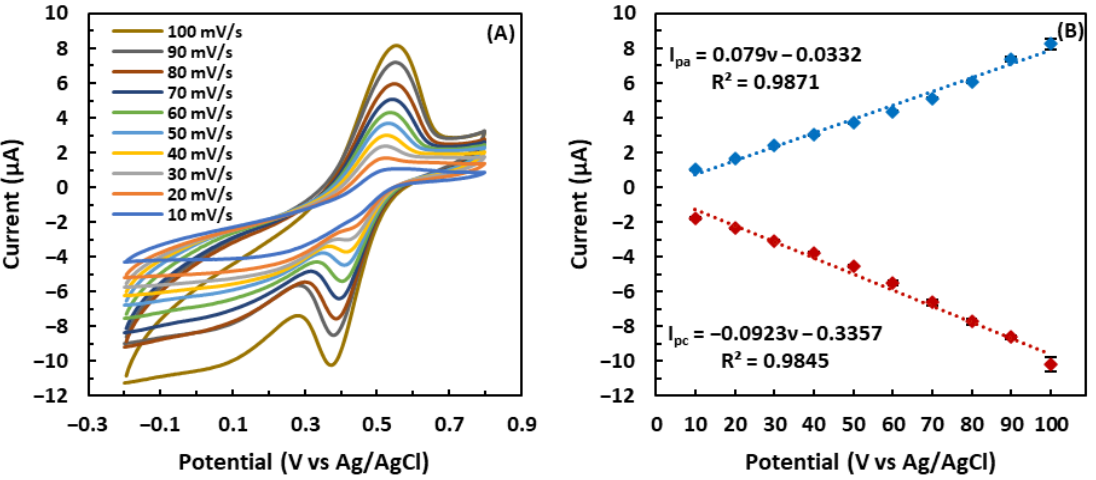
Figure 5. ( A ) Cyclic voltammograms of the GSH-modified electrode at scan rates from 10 mV/s to 100 mV/ s in 5 mM •OH. ( B ) Relationship of the peak current response and the scan rate ( ν ). The error bars indicate the standard deviation of three repetitive